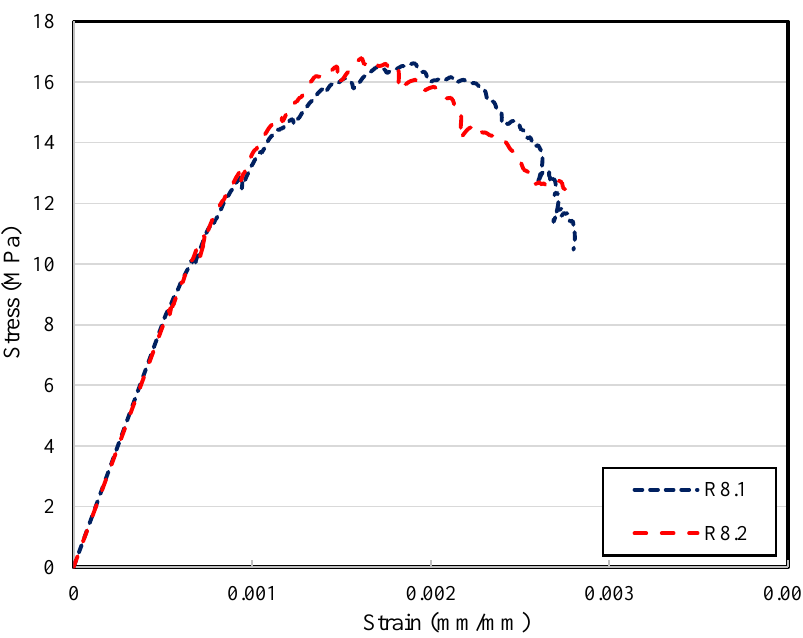
Figure 15. Stress-strain relationship of R7 specimens.